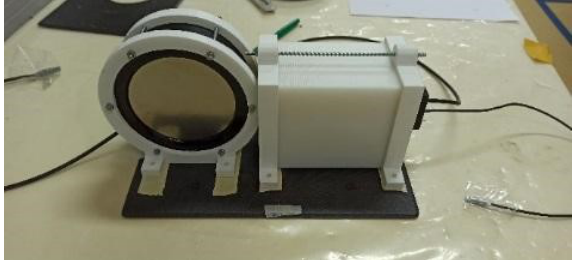
Figure 3. 3D printed detector supports and carbon fiber sandwich sheet developed for detector integration on a mobile platform.